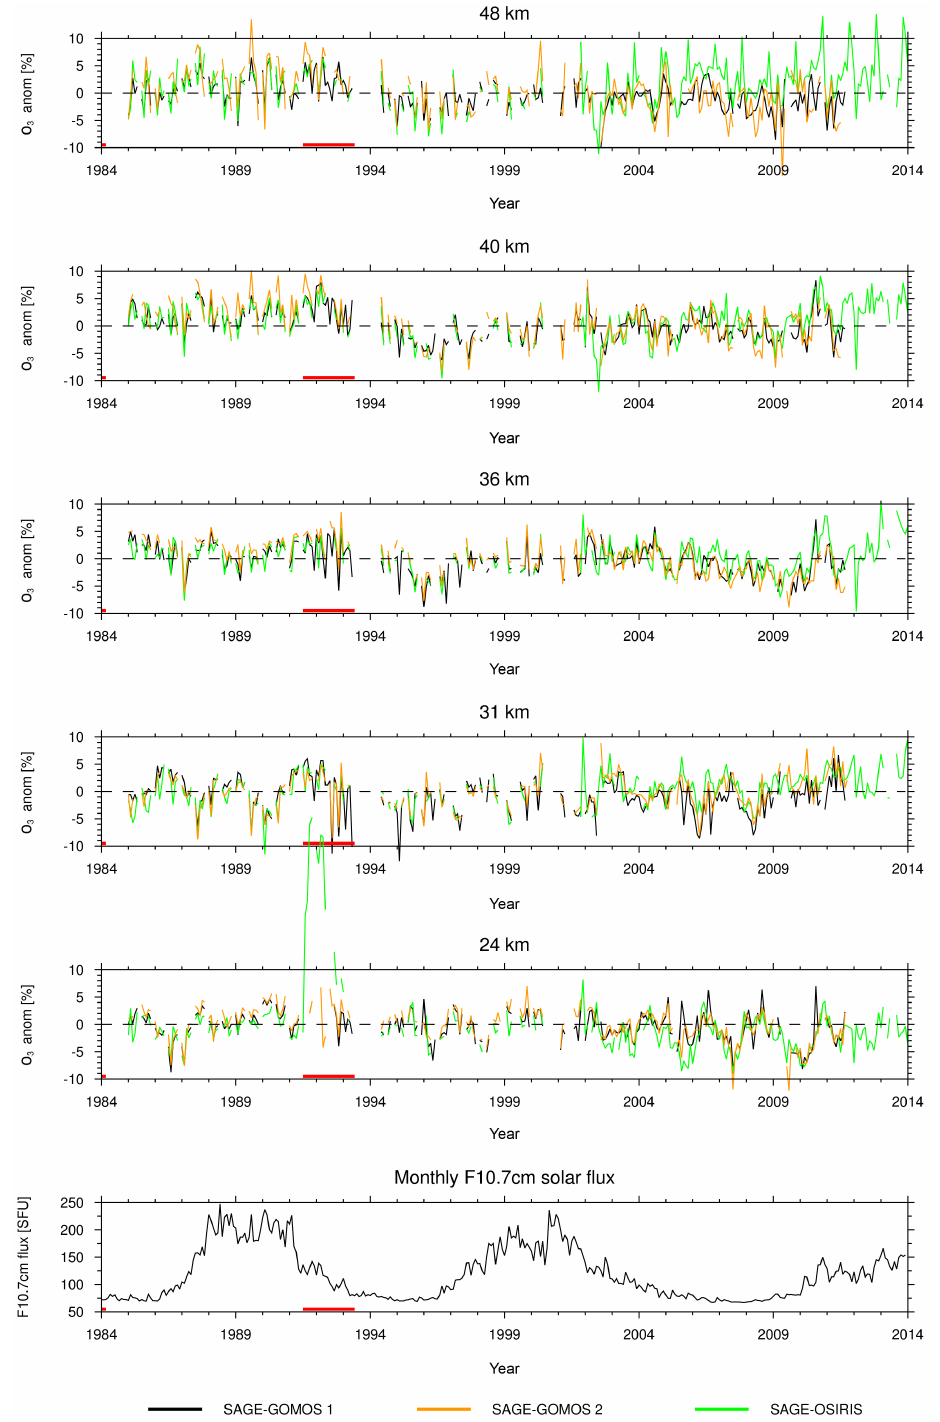
Figure 9. As in Fig. 3 but for the three extended SAGE II number density datasets: SAGE–GOMOS 1 (black), SAGE–GOMOS 2 (orange), and SAGE–OSIRIS (green). The time period is